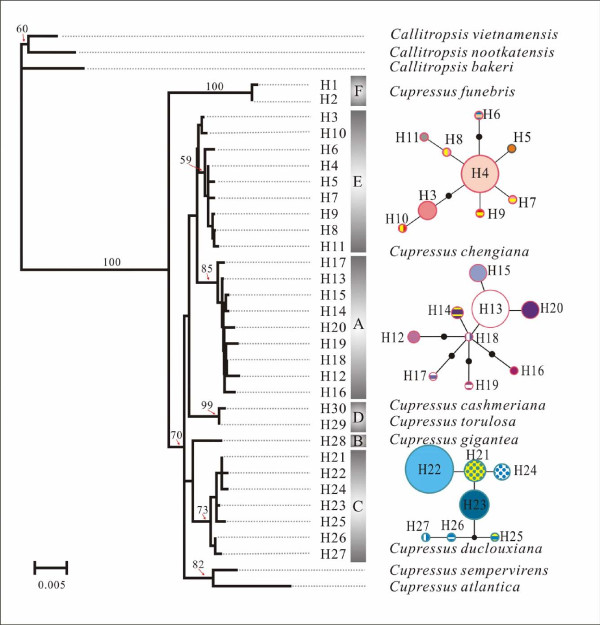
A Neighbor-Joining tree showing phylogenetic relationships between plastid DNA haplotypes. Numbers associated with branches are maximum parsimony bootstrap supports. Circle sizes in network are proportional to haplotype frequencies over all populations; with the largest circle representing the most abundant haplotype and the colours of circles indicating different haplotypes as shown in Fig. 1.